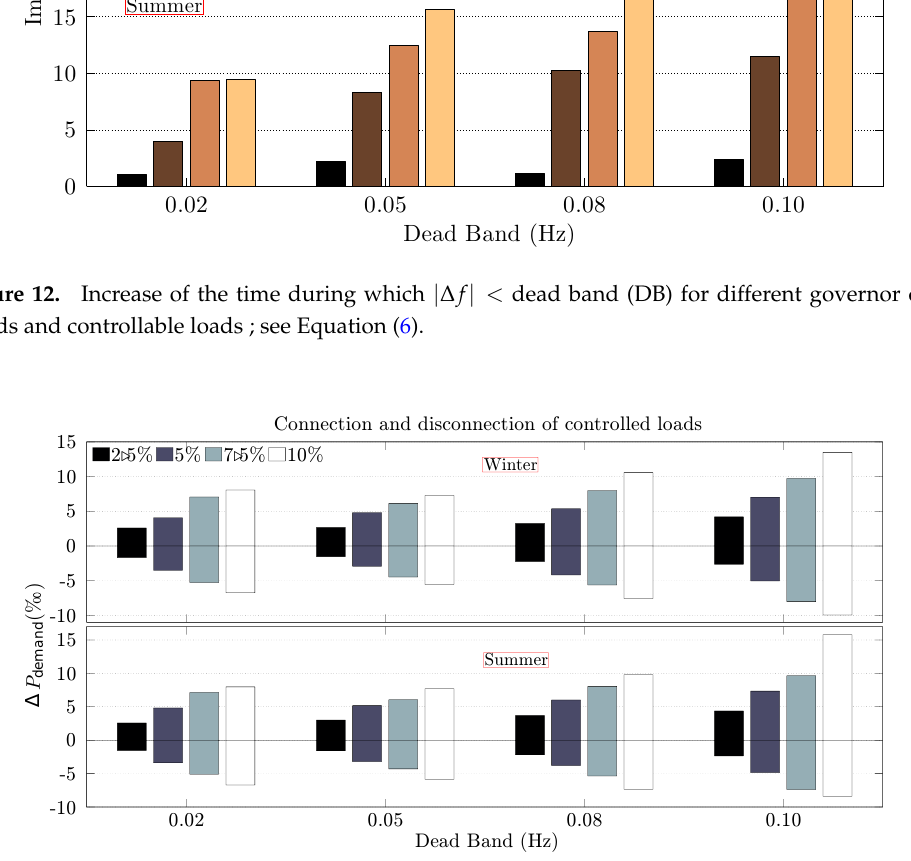
Figure 13. First and 99-percentiles (expressed in ‰) of connected or disconnected controlled loads for different governor dead bands and controllable